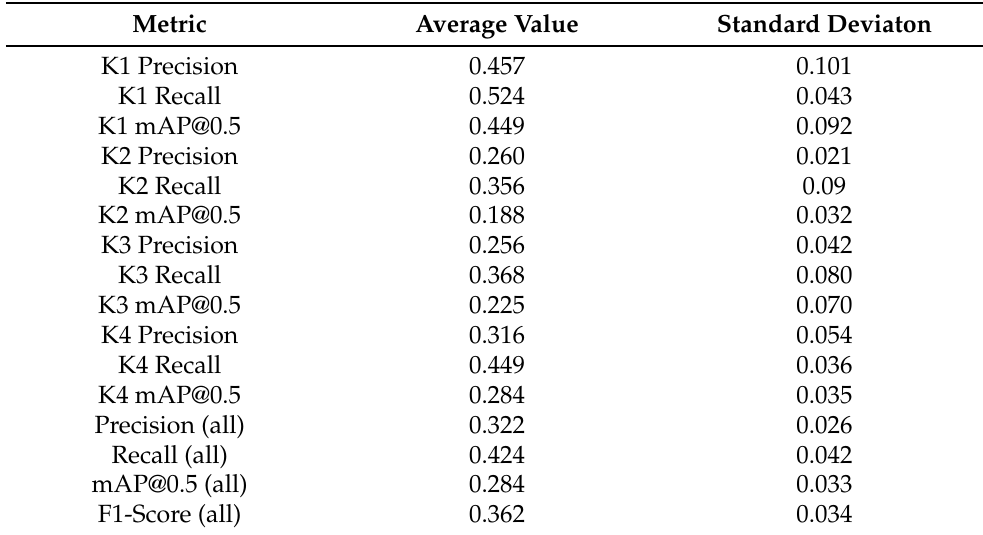
Table 6. Base model evaluation scores.